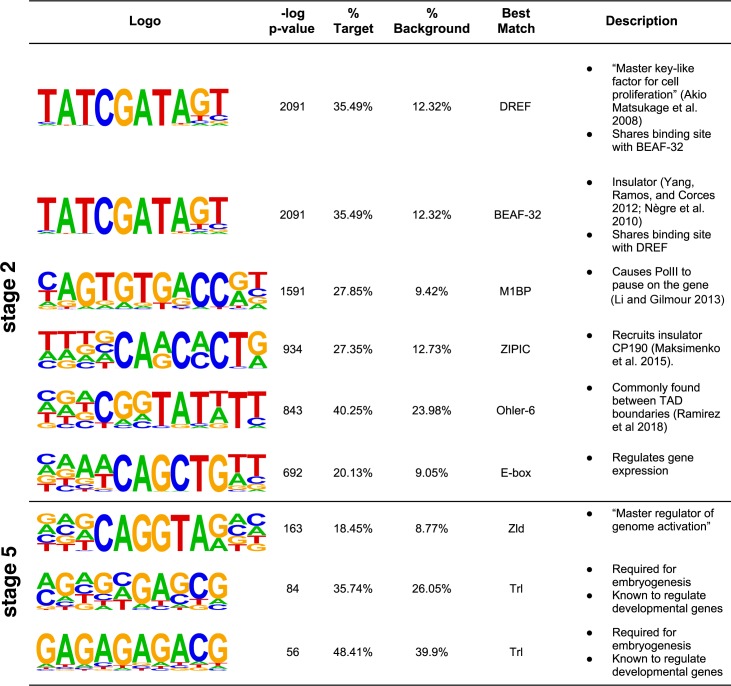
A summary of the top ranked motifs.HOMER was used to find motifs enriched in the 2kb windows upstream of maternally deposited genes (stage 2) and zygotically transcribed genes (stage 5). Sequence logo shows the consensus motif where the probability of each base is proportional to its representative character. P-value is given by HOMER. %target represents the percent of either maternally deposited or zygotically expressed genes that contain at least one instance of the motif. %background indicates the percent of all genes that contain this motif. Best match indicates protein with a previously identified binding site that mostly closely matches the discovered motif (see Methods).